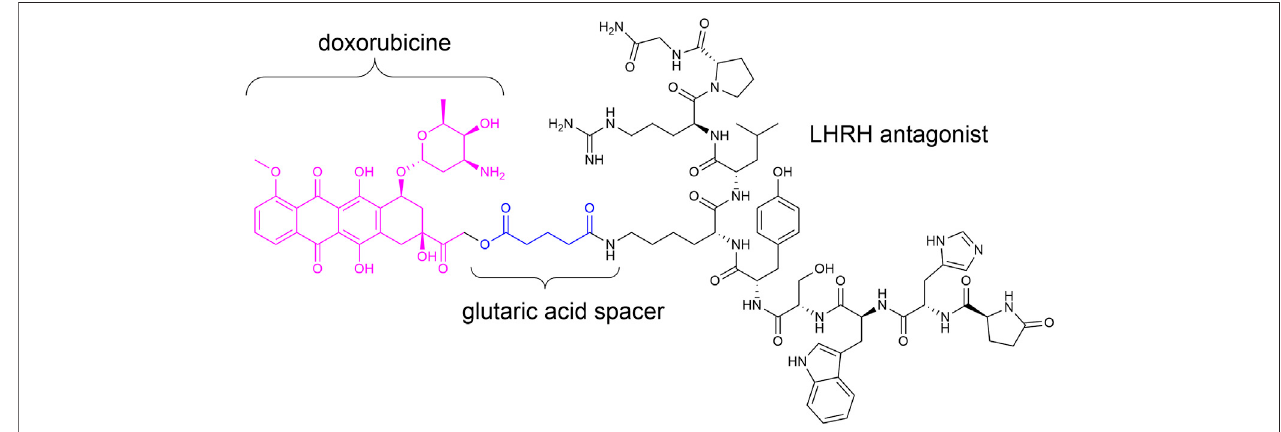
FIGURE 1 | Chemical structure of Zoptrex ™ (Nagy et al.,